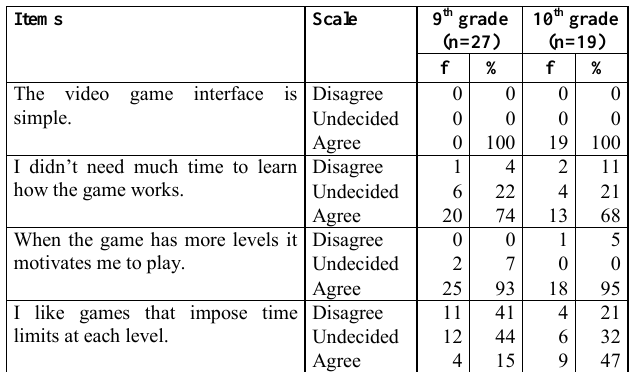
Table 11. Game interface (N =